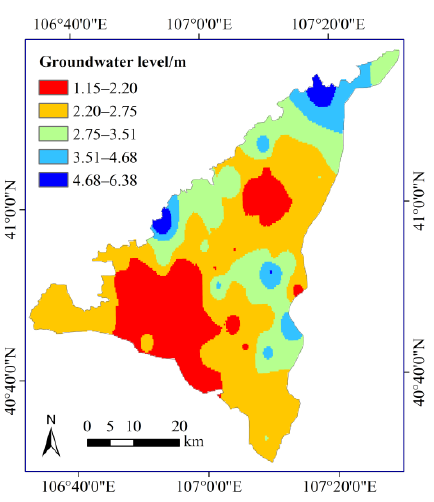
Figure 5. Spatial distribution of the groundwater level in March 2015.